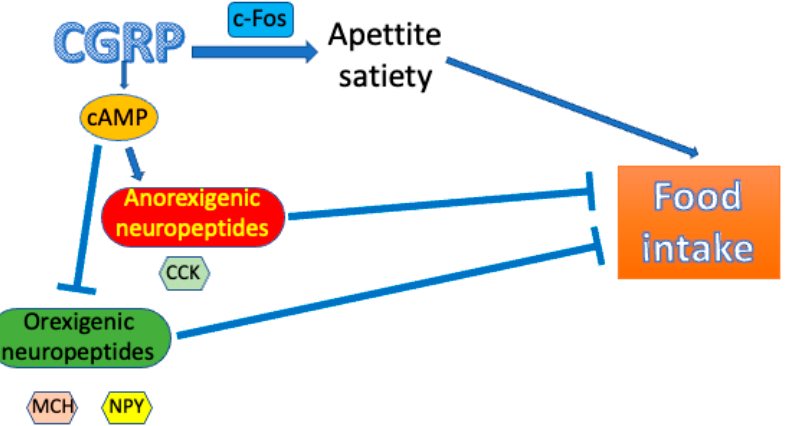
Figure 3. Calcitonin-related gene peptide (CGRP) may exert an anorexigenic effect mediated by c-Fos (Fos proto-oncogene, AP-1 transcription factor subunit) increase through the regulation of appetite and satiety resulting in the modulation of food intake. The regulation of apatite/satiety may be underlined by the upregulation of anorexigenic neuropeptides, including cholecystokinin (CCK) and downregulation of orexigenic neuropeptides, including neuropeptide Y (NPY) and melanin- concentrating hormone (MCH). These effects can be mediated by hypothalamic 3 ′ ,5 ′ -cyclic adenosine monophosphate (cAMP).